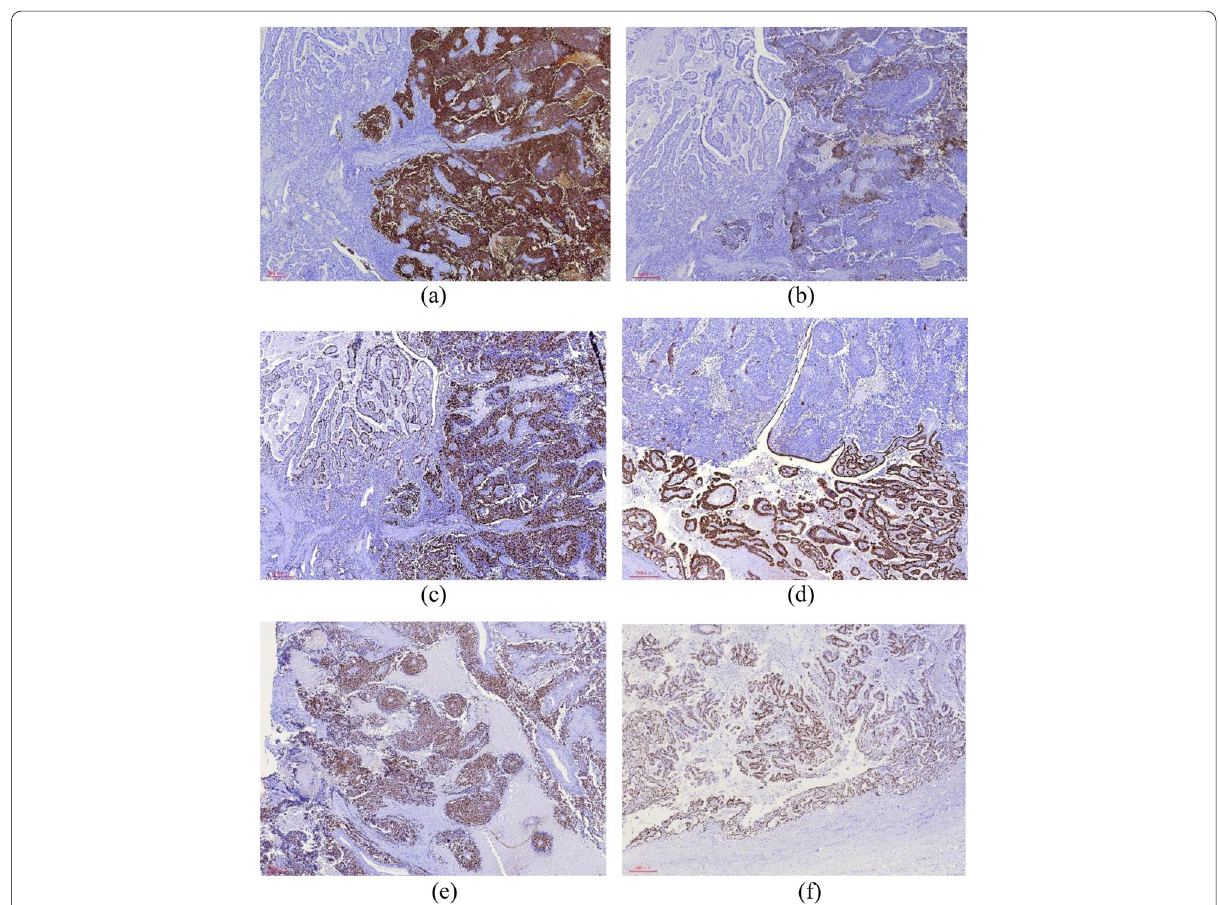
Fig. 5 Case 1: Immunohistochemical staining findings for LCNEC and adenocarcinoma. a Syn staining was diffuse and strongly positive in LCNEC and negative in adenocarcinoma. Magnification, 40. b Staining for CgA was weakly positive in LCNEC and negative in adenocarcinoma area. × Magnification, 40. c High Ki67 proliferation index was found in LCNEC and the adenocarcinoma component. Magnification, 40. d AE1/AE3 × × staining was strongly positive in adenocarcinoma, and punctate weak positive staining was observed in LCNEC. Magnification, 40. e TP 53 staining × showed overexpression in the LCNEC component (left) and in the adenocarcinoma component (upper right). Magnification, 40. f TP 53 staining × also showed overexpression in the adenocarcinoma component (> 80%). Magnification, ×